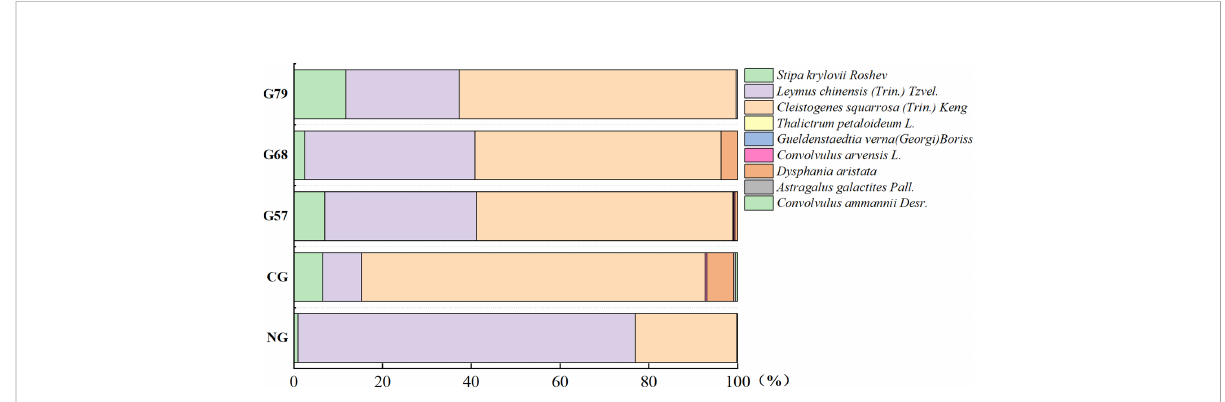
FIGURE 2 Percentage stacked columnar graph of aboveground plant species in fi ve grassland management treatments. NG, CG, G57, G68, G79. NG: No grazing; CG: Continuous grazing; G57: Grazing in May and July; G68: Grazing in June and August; G79: Grazing in July and September.